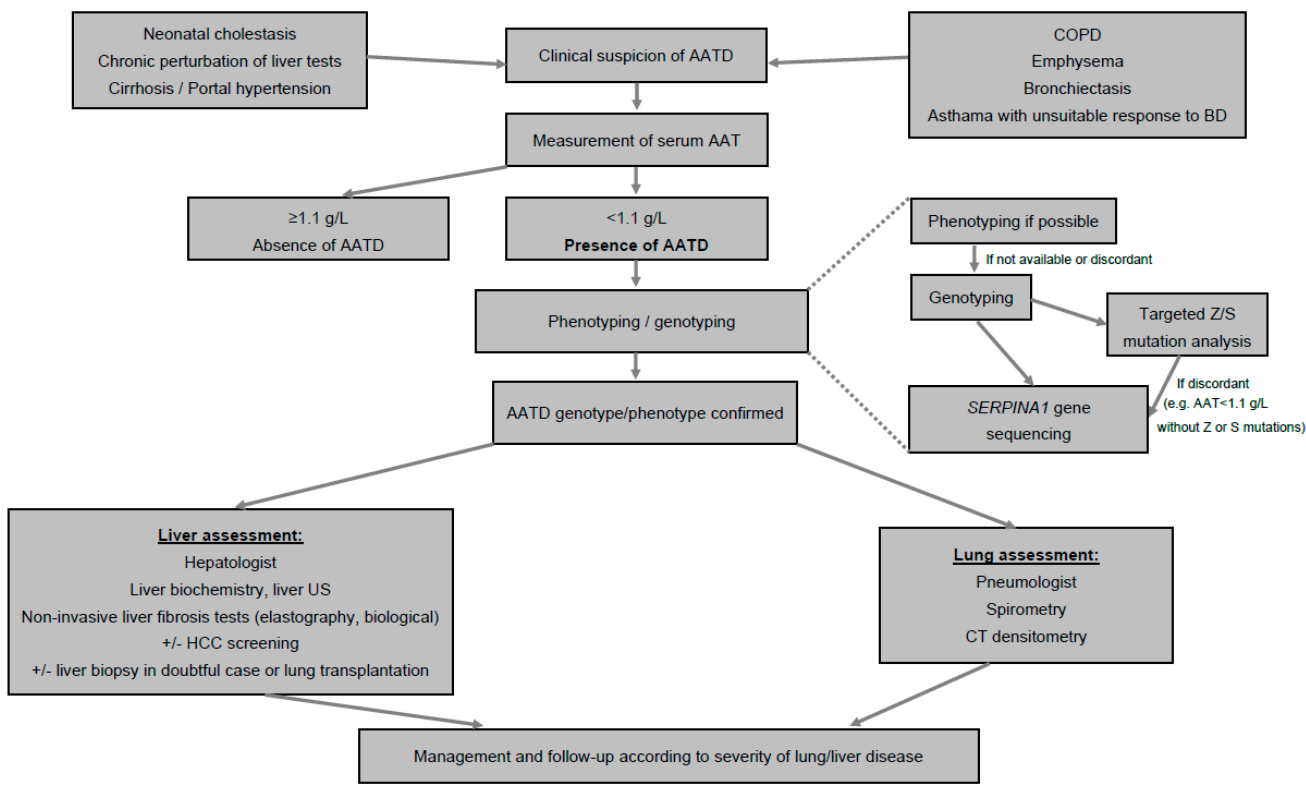
Figure 1. Algorithm for diagnosis of AAT. Abbreviations: AAT, alpha1-antitrypsin; AATD, alpha1- antitrypsin deficiency; COPD, chronic obstructive pulmonary disease; BD, bronchodilators; US, ultrasound; HCC, hepatocellular carcinoma; CT, computed tomography.